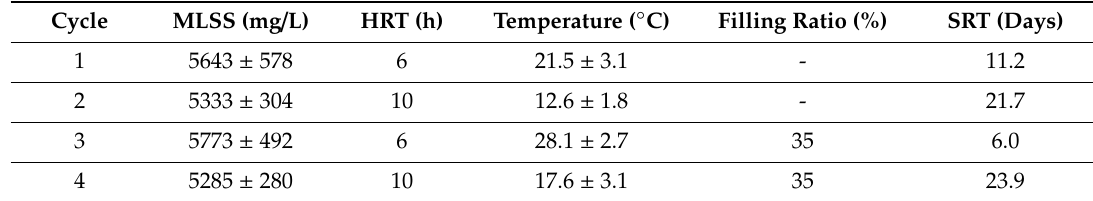
Table 1. Operation variables during the